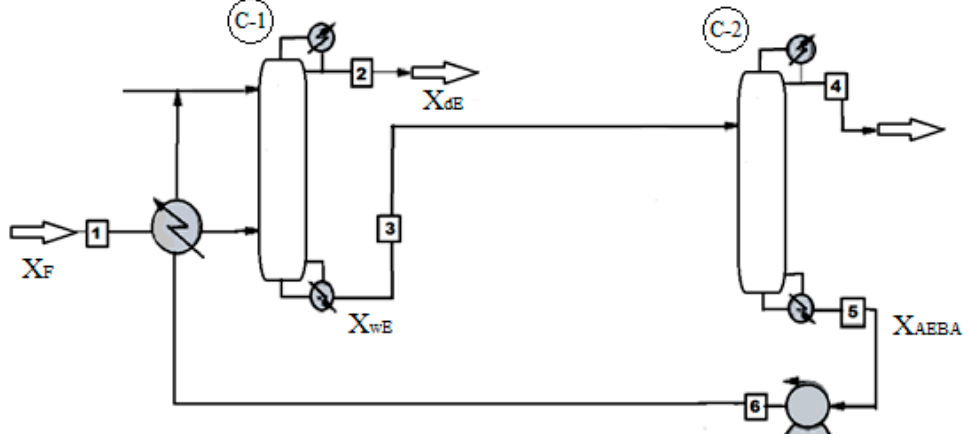
Figure 18. Technology system of ethyl alcohol separation from an aqueous solution process with AEBA-TEG as extractant. Table 2. Results of modeling the process of ethyl alcohol separation from an aqueous solution.